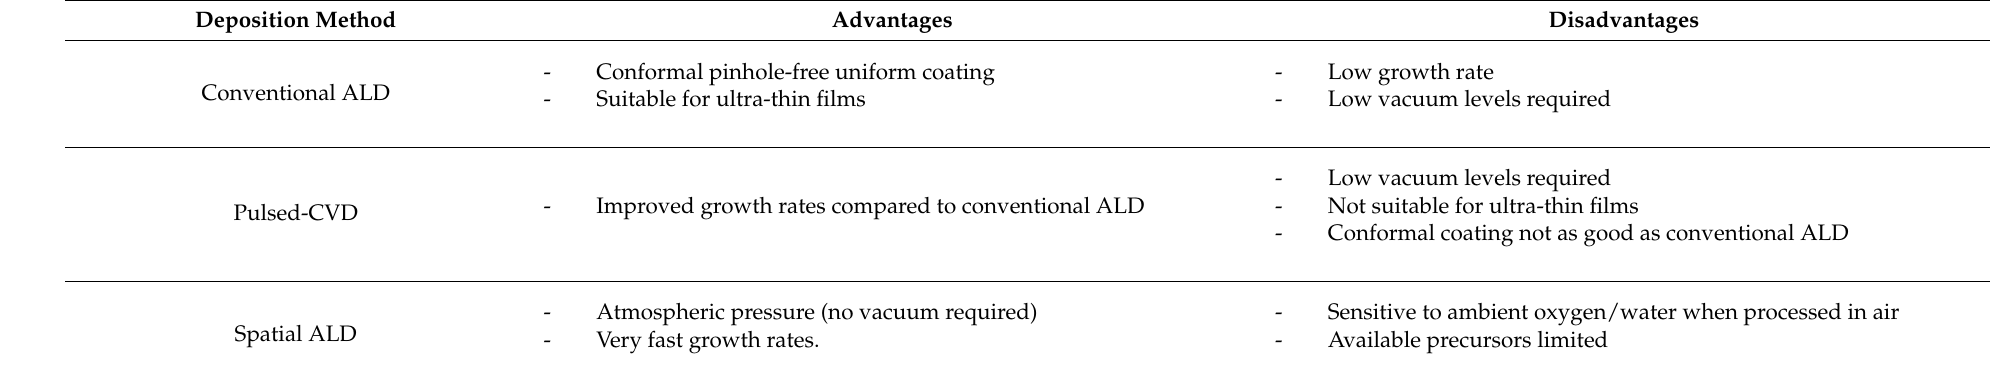
Table 3. Summary of advantages and disadvantages of conventional ALD and its